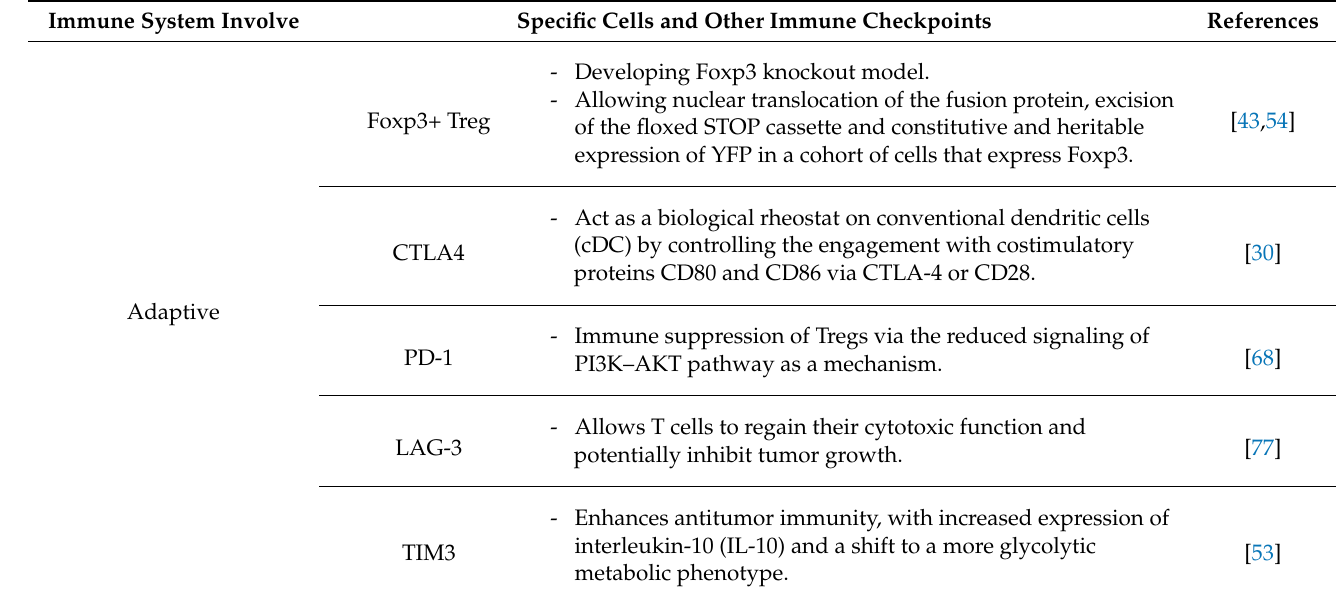
Table 3. Indirect effects of TAM via Foxp3 knockout model.